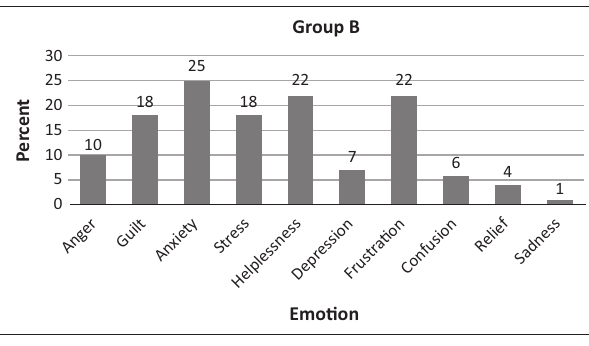
FIGURE 2: Emotions of parents in Group B when their child was diagnosed with